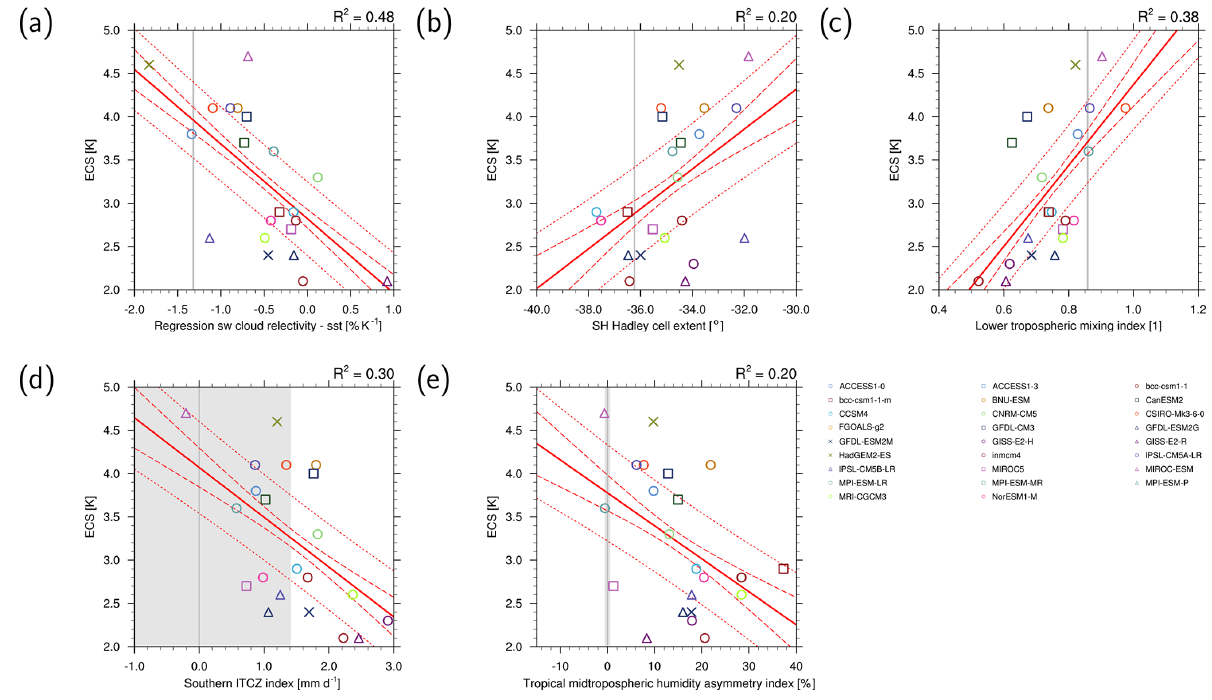
Figure 6. Scatter plots of ECS vs. (a) covariance of shortwave cloud reflection (Brient and Schneider, 2016), (b) Southern Hemisphere (SH) climatological Hadley cell extent (Lipat et al., 2017), (c) lower tropospheric mixing index (LTMI) (Sherwood et al., 2014), (d) south- ern Intertropical Convergence Zone (ITCZ) index (Tian, 2015) and (e) tropical mid-tropospheric humidity asymmetry index (Tian, 2015) for CMIP5 models (symbols). The vertical gray lines represent the observations; the shaded areas in light gray represent observational un- certainties (if available). The solid red lines represent the regression lines, the dashed red lines the 25%/75% confidence intervals of the regression and the dotted red lines the 25%/75% prediction intervals of the regression. Similar to (a) Fig. 6 of Brient and Schneider (2016), (b) Fig. 4 of Lipat et al. (2017), (c) Fig. 5c of Sherwood et al. (2014), (d) Fig. 2 of Tian (2015) and (e) Fig. 4c of Tian (2015). For details on recipe_ecs_scatter.yml , see Sect.